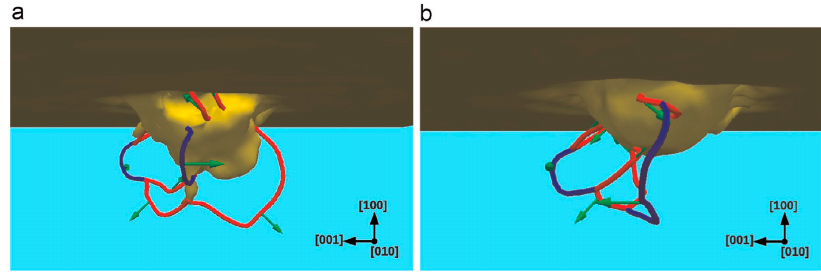
Figure 19. Dislocation structure beneath the indenter during the indentation of Ta (100) surface at 0 K: ( a ) after indent (cid:1858) = 2.7 ; ( b ) after retraction of the indenter (cid:1858) = 2.3 (after Gao et al. [139]).